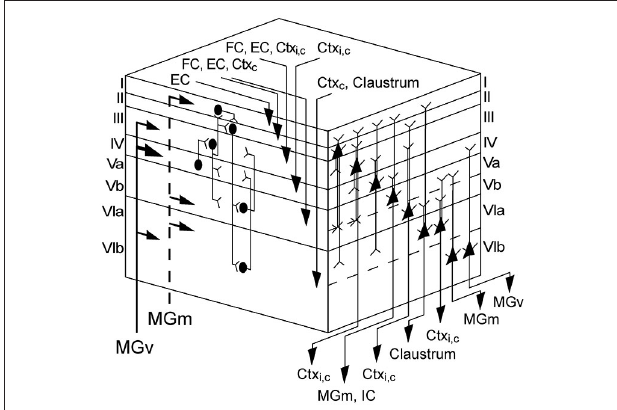
FIGURE 9 | Cortical and laminar network organization of the AC. Left face of cube shows inputs from the ventral (MGv) and medial divisions (MGm) of the geniculate body and cortical areas and a schematic of the interlaminar connections; right face displays the pyramidal neurons of each layer and gives their axonal targets. Note that this schematic drawing illustrates only the major pyramidal neurons. Lemniscal thalamic inputs from MGv mainly arrive at layers III and IV, but also at layer VI. Nonlemniscal inputs from MGm activate layers I, Vb, and VIa. Thalamic activation of layer IV initiates a flow of information into the supragranular layers I–III and then down to the infragranular layers V and VI. Corticocortical inputs from the ipsilateral hemisphere (Ctx i ) terminate in the middle layers III and IV. Commissural inputs (Ctx c ) are widely distributed and arrive in almost all layers (II–VI). Inputs from the claustrum terminate in layer VI, whereas the entorhinal cortex (EC) and frontal cortex (FC) projects to neurons in layers (I) II, III, and V. Pyramidal cells are present in all layers, but layer I. The pyramidal axons of layers II–VI extend into layer I, with the exception of different pyramidal cell types in layers VIa and VIb. Corticocortical projections emerge from layers III, V, and VI. Feed-back to the auditory thalamus originates primarily in layer VI, but also in layer V, which also projects to the inferior colliculus (IC). Adapted from Mitani et al. (1985), Insausti et al. (1997), Linden and Schreiner (2003), Mitchell and Macklis (2005), Thomson and Lamy (2007) and Izhikevich and Edelman